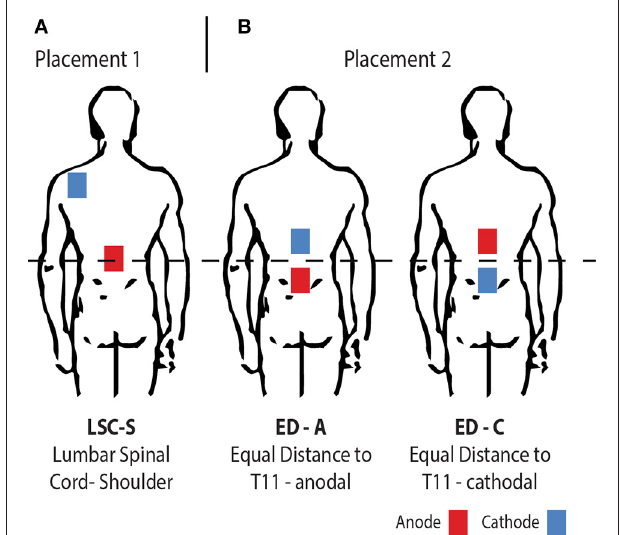
FIGURE 1 | Illustration of the electrode placement configurations investigated. From left to right: (A) The traditionally used placement with one anodal electrode centered on the lumbar spinal cord and a return electrode placed on the left posterior shoulder (LSC-S); (B) Both electrodes placed in equal distance to the lumbar spinal cord, for opposite polarities (ED-A and